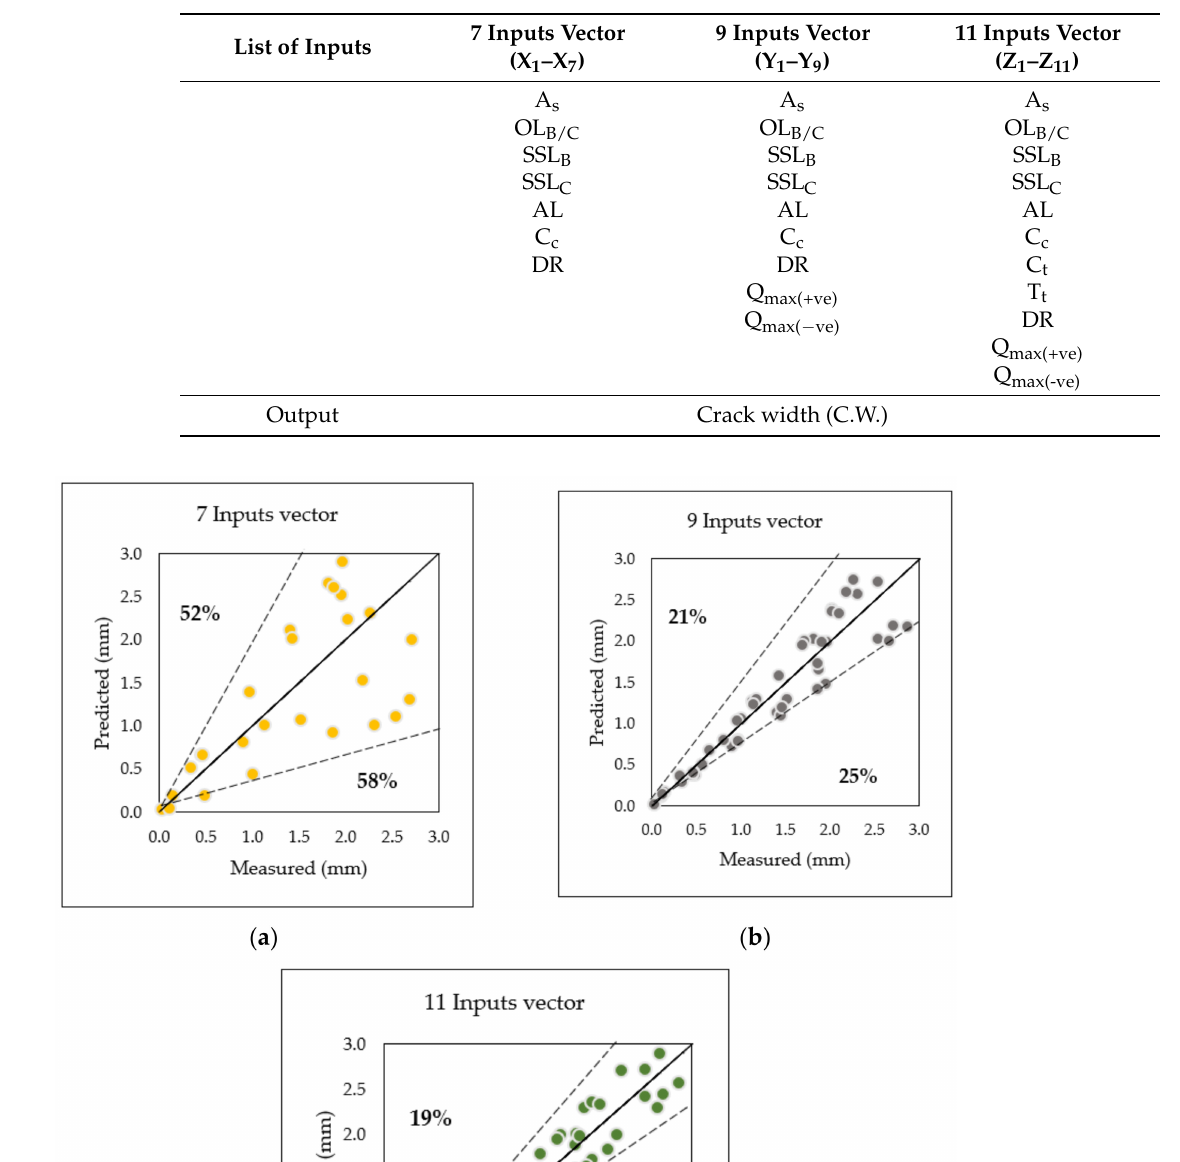
Table 4. Inputs variable vector (7, 9, and 11 inputs).